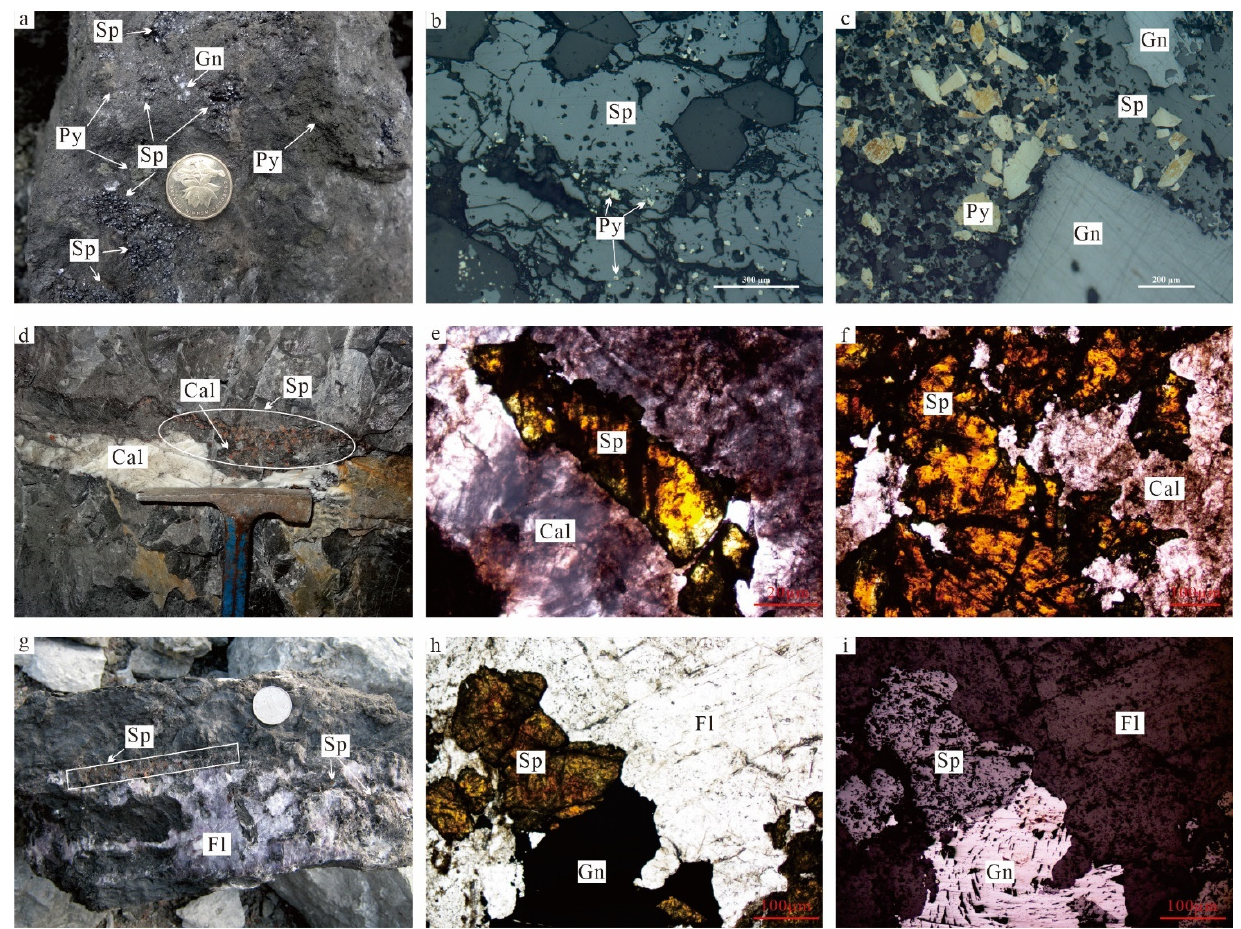
Figure 3. Photos of the samples showing occurrence and mineral phase characteristics of ores. ( a ) massive ore containing dark brown medium-fine grained sphalerite, medium-fine grained galena, and pyrite from the Laochangping Pb-Zn deposit; ( b , c ) sphalerite containing fine grained pyrite and galena under the reflected light microscope from the Laochangping Pb-Zn deposit; ( d ) underground exposure at the Laoxi orebody of the Luota Pb-Zn deposit, illustrating banded sphalerite (up) in contact with the calcite veins (down) hosted in the limestone; ( e , f ) light brown fine grained sphalerite coexist with calcite under the transmission light microscope from the Laoxi orebody; ( g ) purple fluorite coexisting with sphalerite from the Wujiahe orebody of the Luota Pb-Zn deposit; ( h , i ) light brown fine grained sphalerite coexisting with fine grained galena and fluorite under the microscope from the Wujiahe orebody of the Luota Pb-Zn deposit. Mineral abbreviations: Sp—sphalerite; Gn—